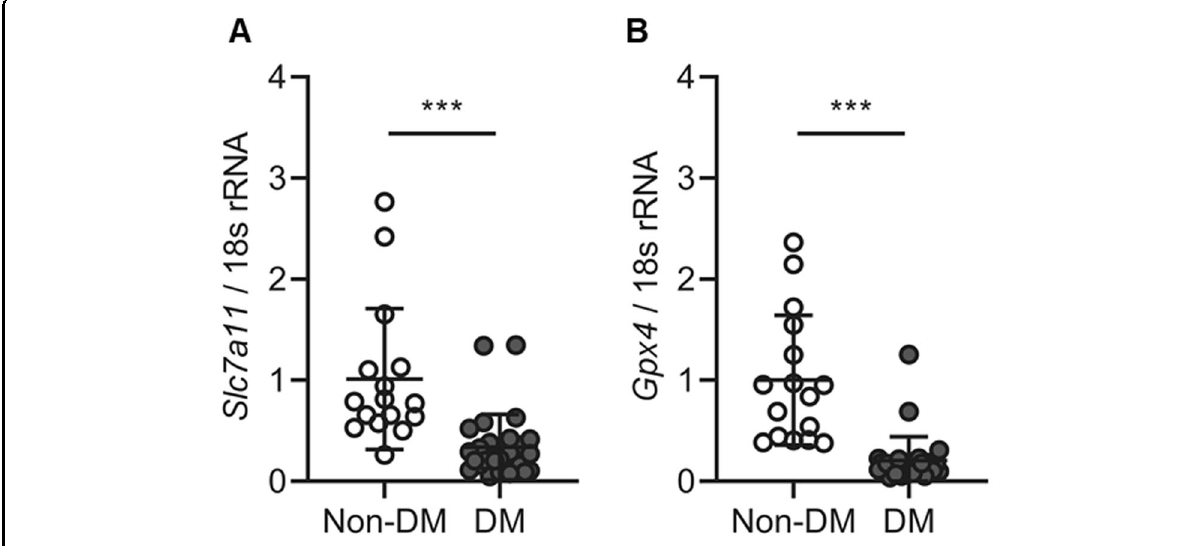
Fig. 1 Expression of ferroptosis-related molecules Slc7a11 and Gpx4 was decreased in diabetic nephropathy of kidney biopsy tissues. A , B Slc7a11 and Gpx4 mRNA expression was signi fi cantly decreased in the DM group compared to the non-DM group. Bonferroni t tests were used for statistical analysis. Error bars represent SD. *** P < 0.001 versus non-DM group; non-DM group, n = 17; DM group, n =